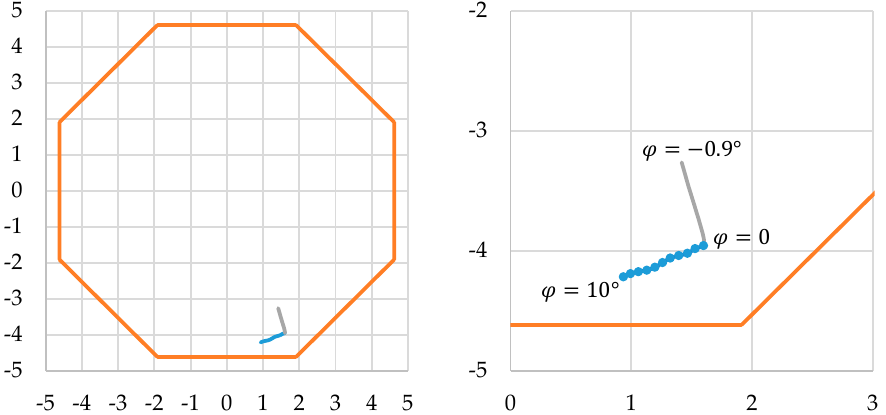
Figure 6. Position of the laser beam at the exit face in dependence of the torsion angle. Blue: 10° ≥ 𝜑 ≥ 0 , grey: 0 ≥ 𝜑 ≥ −0.9° , orange: shape of the exit face. Dots in enlarged diagram for each full degree of 𝜑 . Dimensions are in mm .